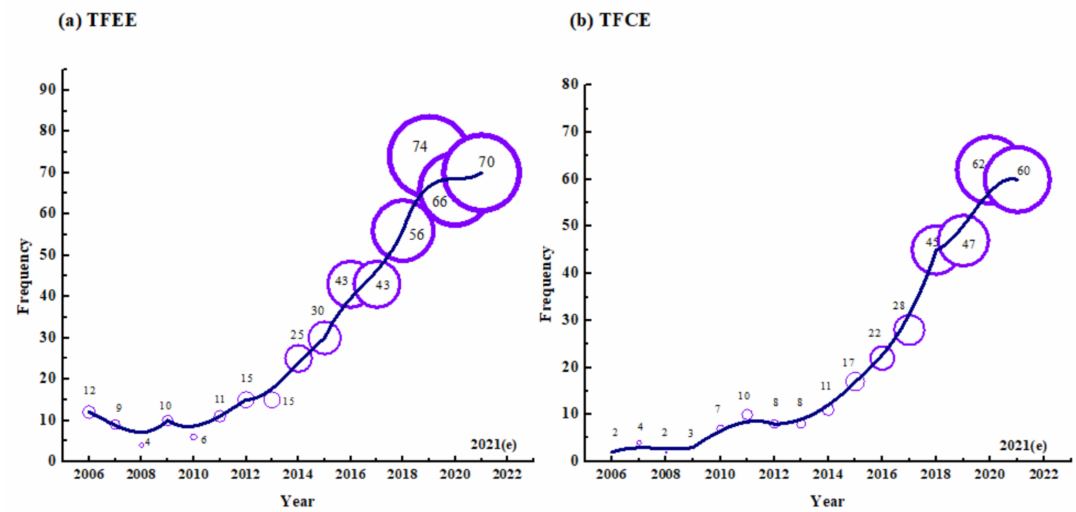
Figure 1. The number of TFEE ( a ) and TFCE ( b ) publications from 2006 to